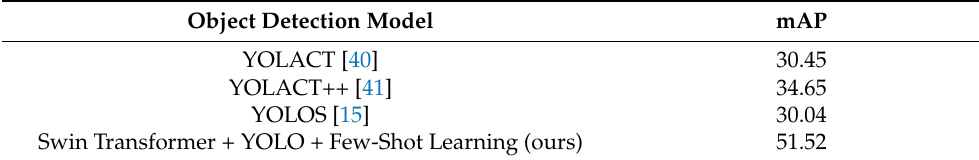
Table 2. The results of the performance comparison between object detection